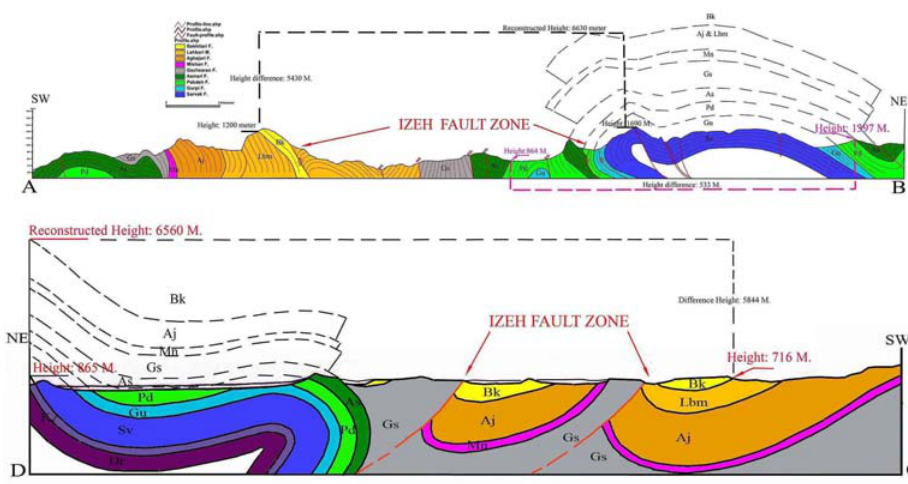
Figure 6. Cross sections together with subsidence-uplifting.